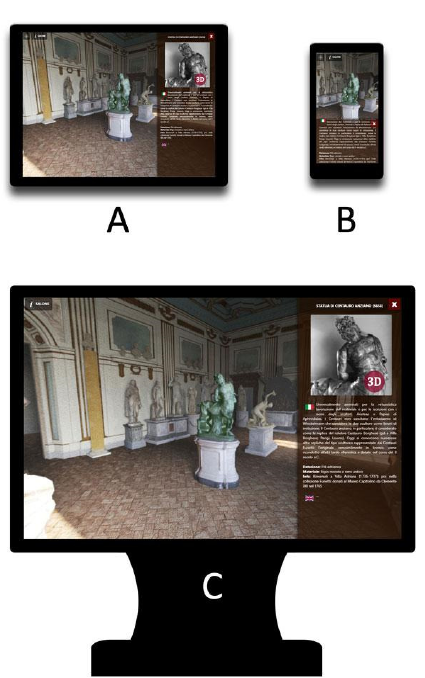
Figure 9. Hand-held devices responsiveness (A and B)